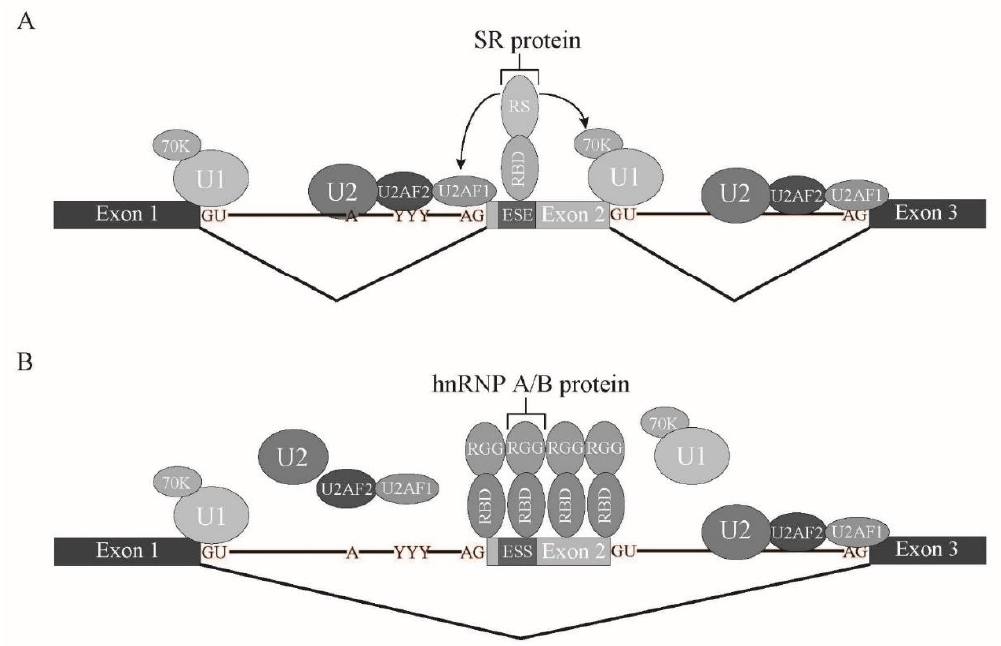
Figure 4. Models for promotion or inhibition of exon recognition by SR proteins or hnRNP A/B proteins, respectively. ( A ) SR proteins bind to exonic splicing enhancer (ESE) through their RNA binding domain (RBD). They interact with U2AF1 and U1 70K proteins via interactions between their Arginine-Serine-rich (RS) domains, which promotes exon recognition. U1, U2: U1, U1 small nuclear ribonucleoprotein, U2 small nuclear ribonucleoprotein. U2AF1, U2AF2: U2 snRNP auxiliary factor 1, 2. ( B ) hnRNP A/B proteins bind to the exonic splicing silencer (ESS) via their RBD and can spread on pre-mRNA in both 5′ and 3′ directions. This results in covering the exon and other regions on pre-mRNA and prevents association of splicing factors. Consequently, this exon tends to be excluded. RGG: Arginine-Glycine-Glycine repeat-rich domain.